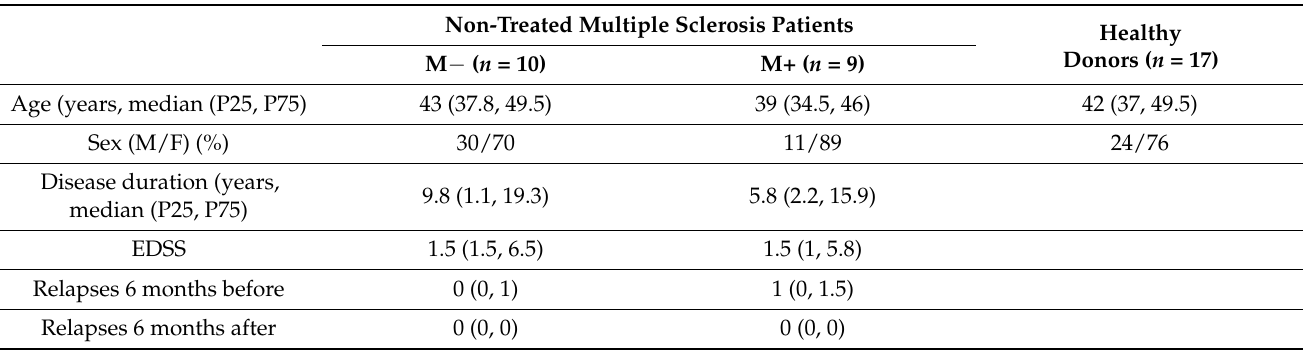
Table 1. Demographic and clinical characteristics of the patients and healthy donors included in this